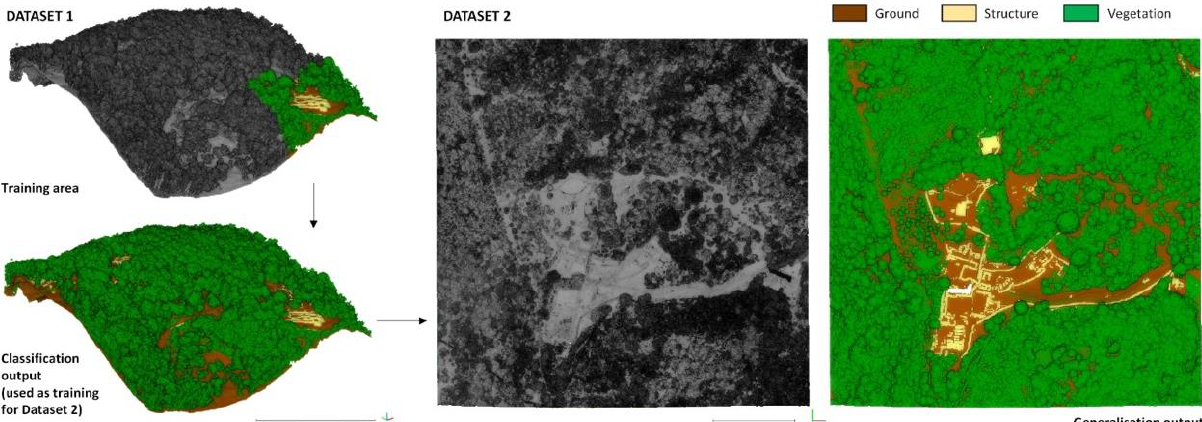
Figure 7. Classification results achieved generalising knowledge acquired in Dataset_1 ( San Martino ai Campi archaeological area) to Dataset_2 ( Roselle archaeological